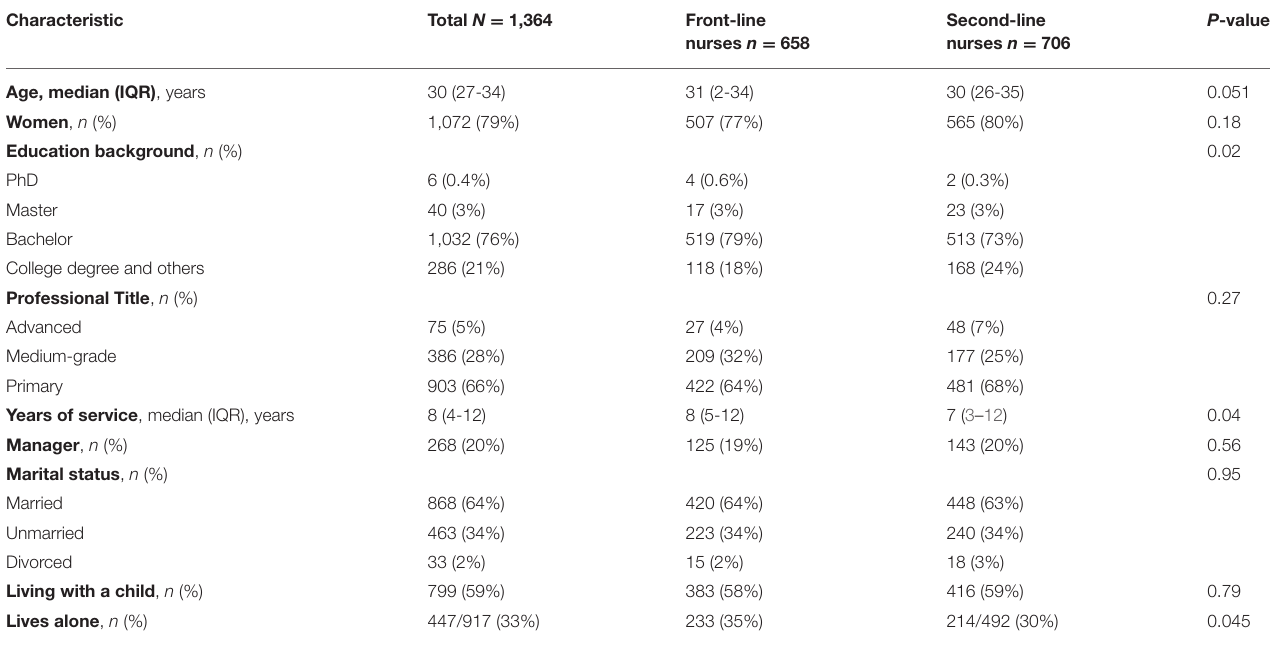
TABLE 2 | Demographic characteristics of All 1,364 Chinese